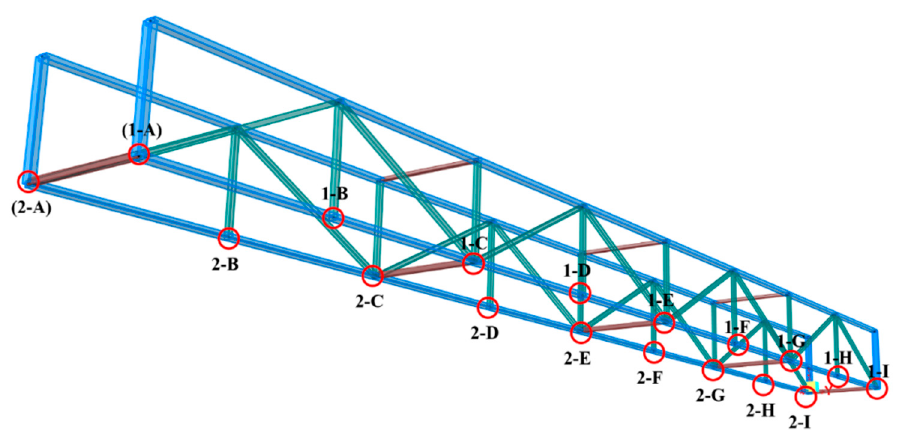
Figure 7. The distribution of the loading points. Table 1. The loading position and the level of loading in each case.